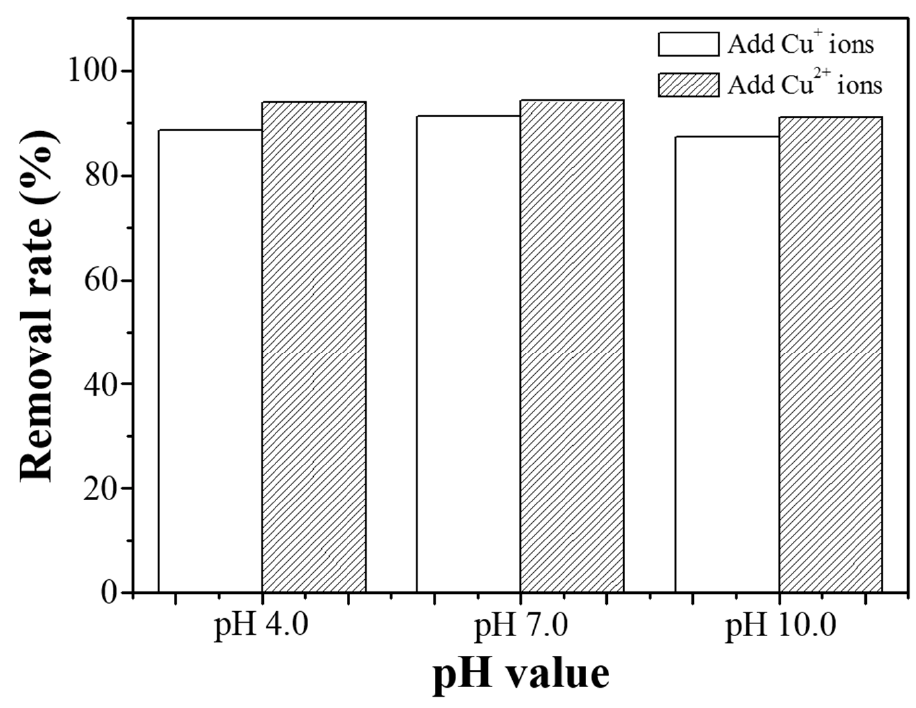
Figure 13. RhB degradation efficiency by the H-CuFeS 2 samples at different pH value system in the presence of copper ions.